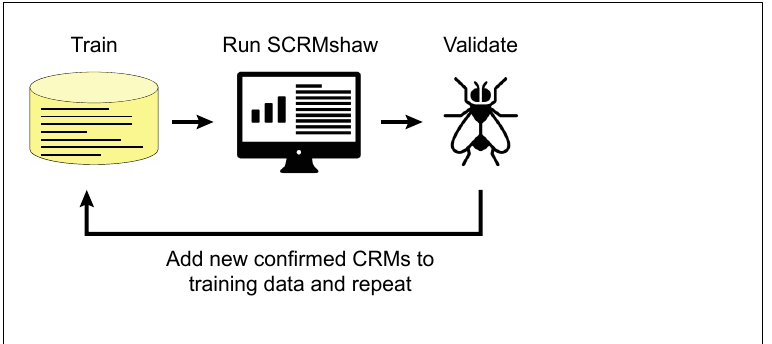
Figure 3. Iterative search and validation. Sequences validating as true CRMs from an initial SCRMshaw search can be added back to the training set, and the new, enlarged training set used for a subsequent round of predictions. This strategy can effectively compensate for an initially weak training set. Images downloaded from TheNounProject.com (accessed on 28 April 2021), “Fly” by Georgiana Ionescu, and “analytics” by Wilson Joseph, under the CC ‐ BY license.